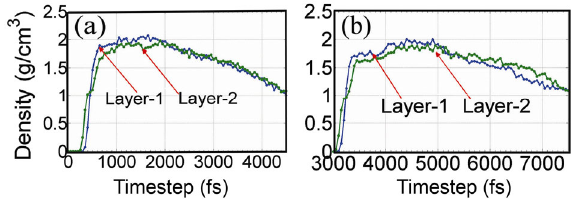
Fig. 5 The average density variation curve with time of the water film layer on the substrate surface: (a) Pos20; (b) Pos150.